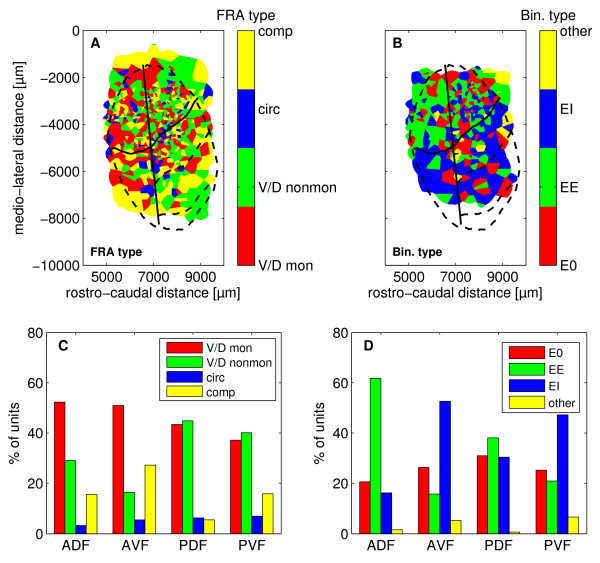
Spatial representation of FRA types and binaural response types and distribution in different cortical subfields. Spatial representation A) and distribution in cortical subfields C) of the different FRA types. V/D mon: monotonically V-shaped/double-tuned; V/D nonmon: non-monotonically V-shaped/double-tuned; circ: circumscribed; comp: complex. Spatial representation B) and distribution in cortical subfields D) of the different binaural response types. EI: Excitatory/inhibitory; EE: Excitatory/excitatory; E0: Excitatory/non-responsive. Abbreviation of field names as in Fig. 1C.